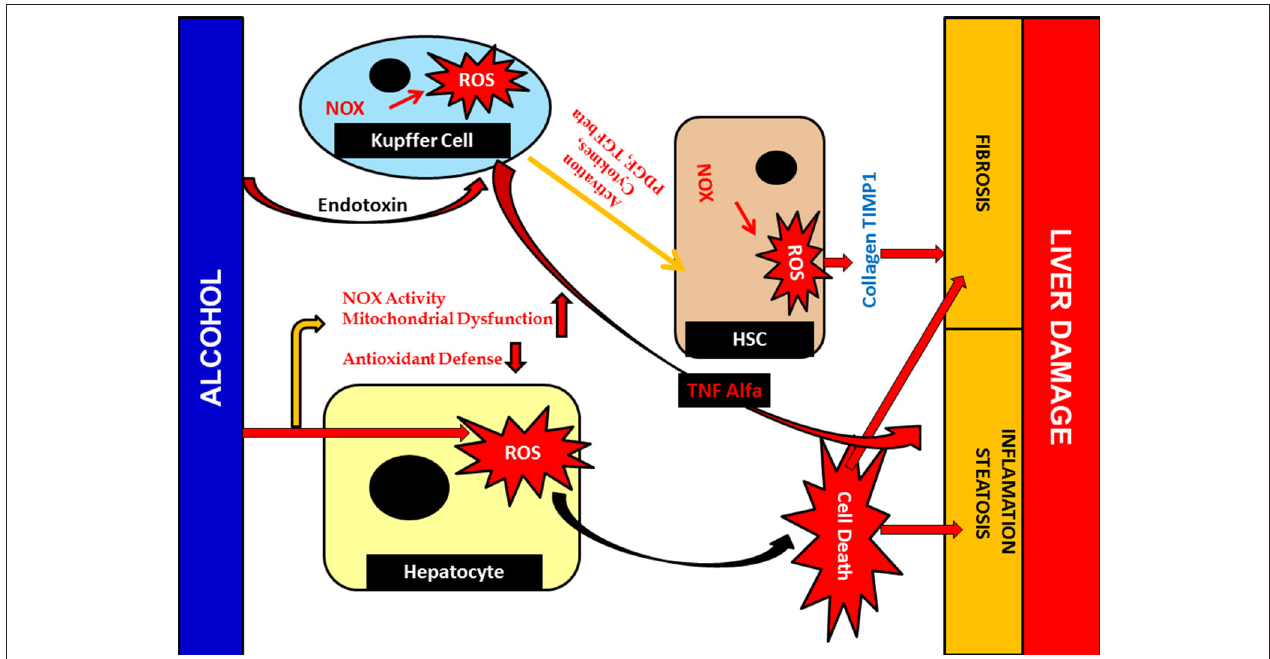
FIGURE 9 | Alcohol mediated Hepatotoxicity. Hepatotoxicity caused by increased production of ROS; due to alcohol damages antioxidant defenses and mitochondrial function as well as structure. It leads to liver inflammation, fibrosis and steatosis. Cellular responses, which are sturdily involved in Kupffer cell may also activated due to action of ROS which contribute to an increase of inflammatory responses, resulting liver injury. Furthermore, activated Kupffer cells release ROS and cytokines that are crucial for HSC activation and inducing the pro-fibrogenic